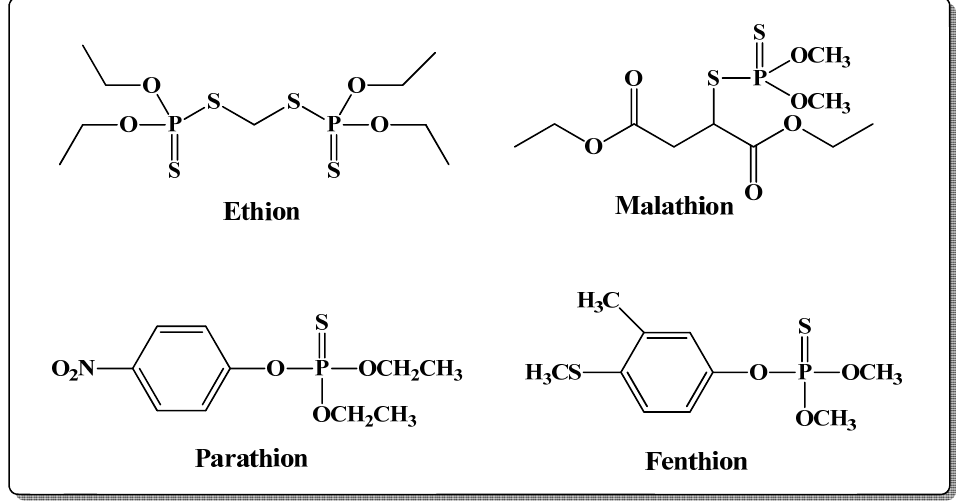
Figure 12. Chemical structures of ethion, malathion, parathion, and fenthion